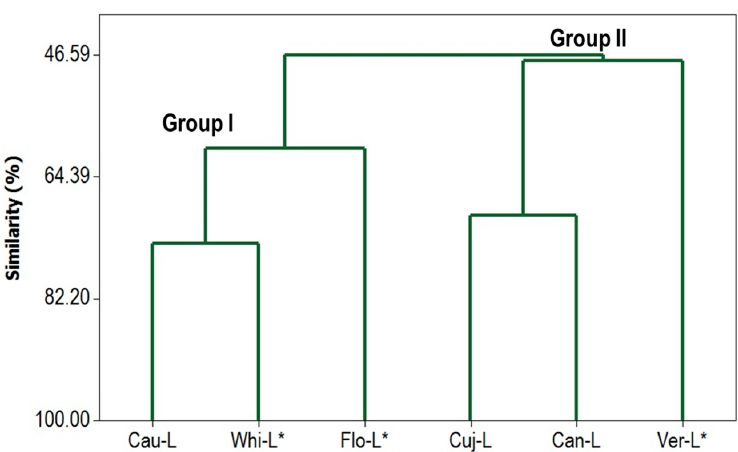
Figure 2. Dendrogram with Complete Linkage and Correlation Coefficient Distance. * Literature data (Takaku et al., 2007 [21]).